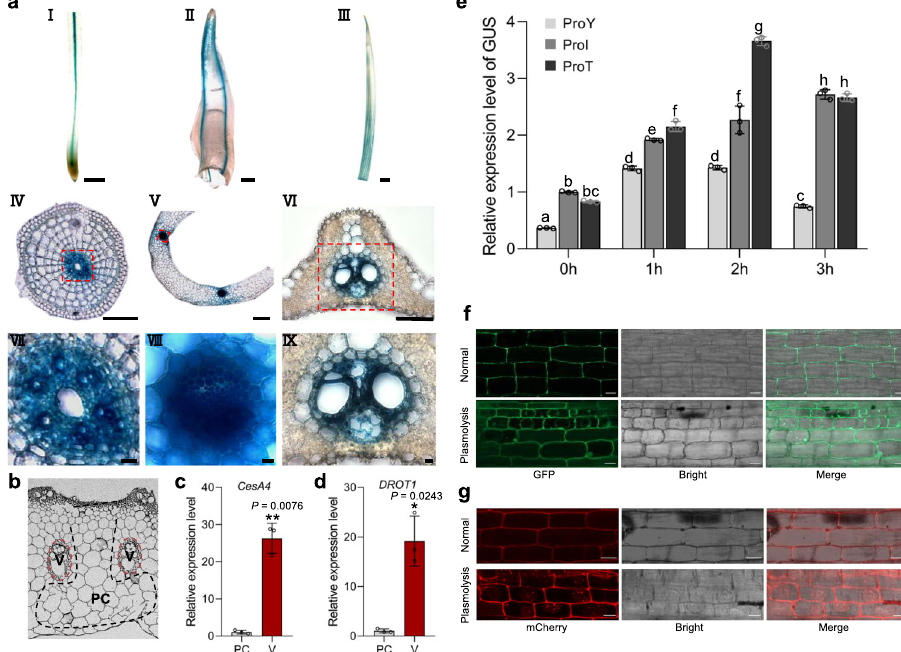
Fig. 3 Expression patterns of DROT1 and its subcellular localization. a GUS staining. (I) Root. (II) Coleoptile. (III) leaf of seedling. (IV, V, and VI) Cross- sections of I, II and III separately. (VII, VIII, and IX) Magni fi cation of the region framed by red box in IV, V, and VI, respectively. Scale bar, 500 μ m in I-III, 200 μ m in IV-VI, 20 μ m in VII – IX. n = 5 biological replicates. b Schematic diagram of parenchyma cells (PC, indicated by black dashed line) and vascular bundles (V, indicated by red dashed line) in the cross-sections of rice internodes for microdissection. c , d qRT-PCR analysis of the vascular bundle-speci fi c marker gene CesA4 ( c ) and DROT1 ( d ) in harvested cells or tissues as indicated in b . Data are means± s.d. ( n = 3 biological replicates). Asterisks indicate statistical signi fi cance by two-tailed Student ’ s t -tests (* P < 0.05, ** P < 0.01). e Expression of GUS gene promoted by different types of DROT1 cis -elements. Three vectors containing GUS reporter gene driven by the promoter ProY (the promoter of DROT1 from Yuefu), ProI (the promoter of DROT1 from IRAT109) or ProT (the promoter of DROT1 from Yuefu with the SNP s18975900 changed from C to T) were introduced into Nipponbare, respectively. Data are means ± s.d. ( n = 3 biological replicates). Different letters indicate statistically signi fi cant differences at P = 0.01 by one-way ANOVA. f , g Subcellular localization of DROT1. Seedlings root tissues of transgenic rice containing vector proDROT1::DROT1-GFP ( f ) or proDROT1::DROT1-mCherry ( g ) were observed by confocal laser-scanning microscopy, respectively. n = 3 independent experiments. The plasmolysis in the cells occurred by treated root tissues with 1 M sorbitol for 15 min. Bars = 20 μ m. Source data are provided as a Source Data fi